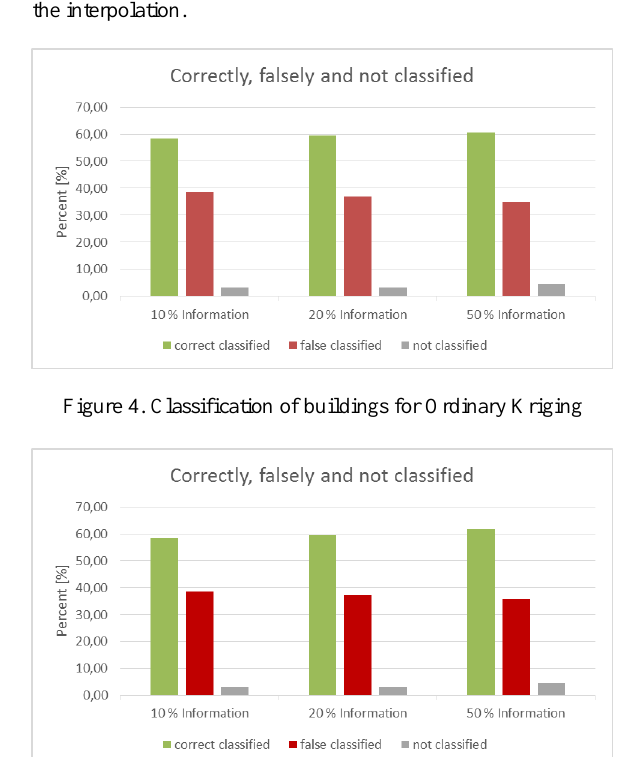
Figure 5. Classification of buildings for Universal Kriging Fig. 4 (Ordinary Kriging) and fig. 5 (Universal Kriging)